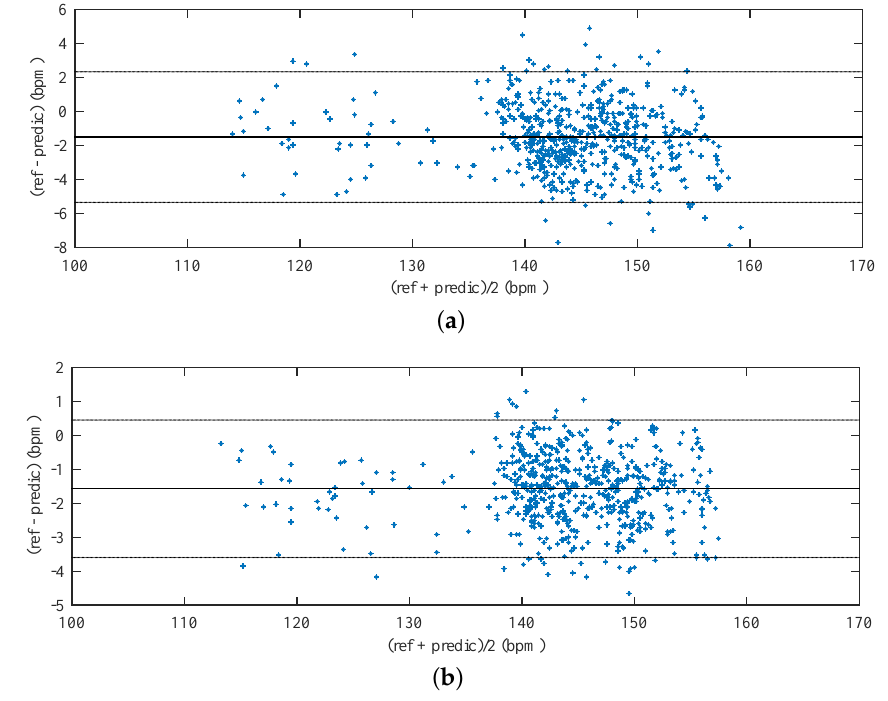
Figure 14. Bland-Altman statistics for reference and predicted values of fHR for ( a ) the LMS Algorithm; ( b ) The NLMS